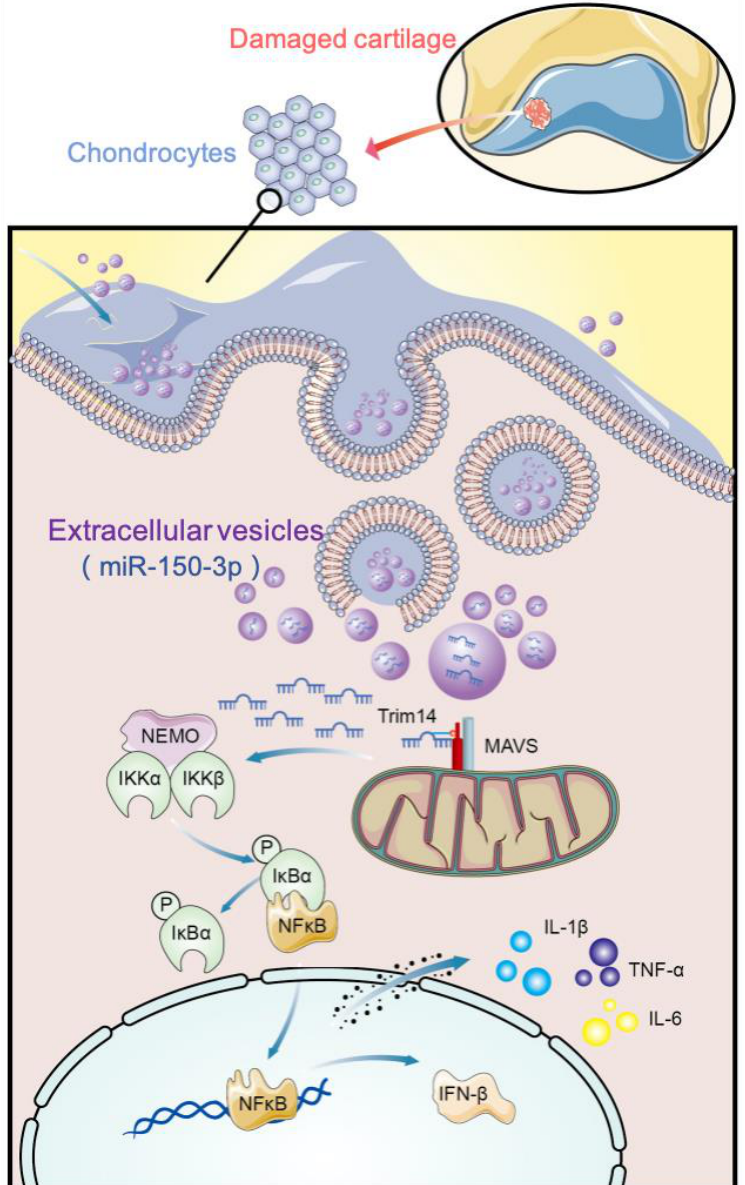
Figure 13. Therapeutic mechanisms of FLS-derived EVs-150. EVs released by the FLSs in the healthy SM were collected, and these EVs could deliver miR-150-3p to chondrocytes. When OA occurs, Trim14 is recruited to the IKK complex by binding to NEMO, a large multi-unit complex that consists of two catalytic subunits (IKK α and IKK β ) and the regulatory subunit IKK γ (which is also known as NEMO, an essential modulator of NF- κ B expression). IKK promotes the phosphorylation of I κ B α and p65 as well as NF- κ B activation and IFN- β expression. After the immune response was activated, the primary pro-inflammatory cytokines IL-1 β , IL-6, and TNF- α were expressed, and the various cytokines and chemokines were synthesized and released. Some of these inflammatory mediators were detected in the joint tissues and synovial fluid of OA rats. These mediators can accelerate chondrocyte degradation and metabolism, thereby injuring the joint and causing a series of clinical symptoms. EVs-150 from healthy FLSs could regulate the mRNA level of the target gene Trim14, thereby effectively inhibiting the activation of the positive feedback loop formed by the Trim14/NF- κ B/IFN- β axis of the innate immune response, consequently exerting a suppressive effect on the OA processes indicated